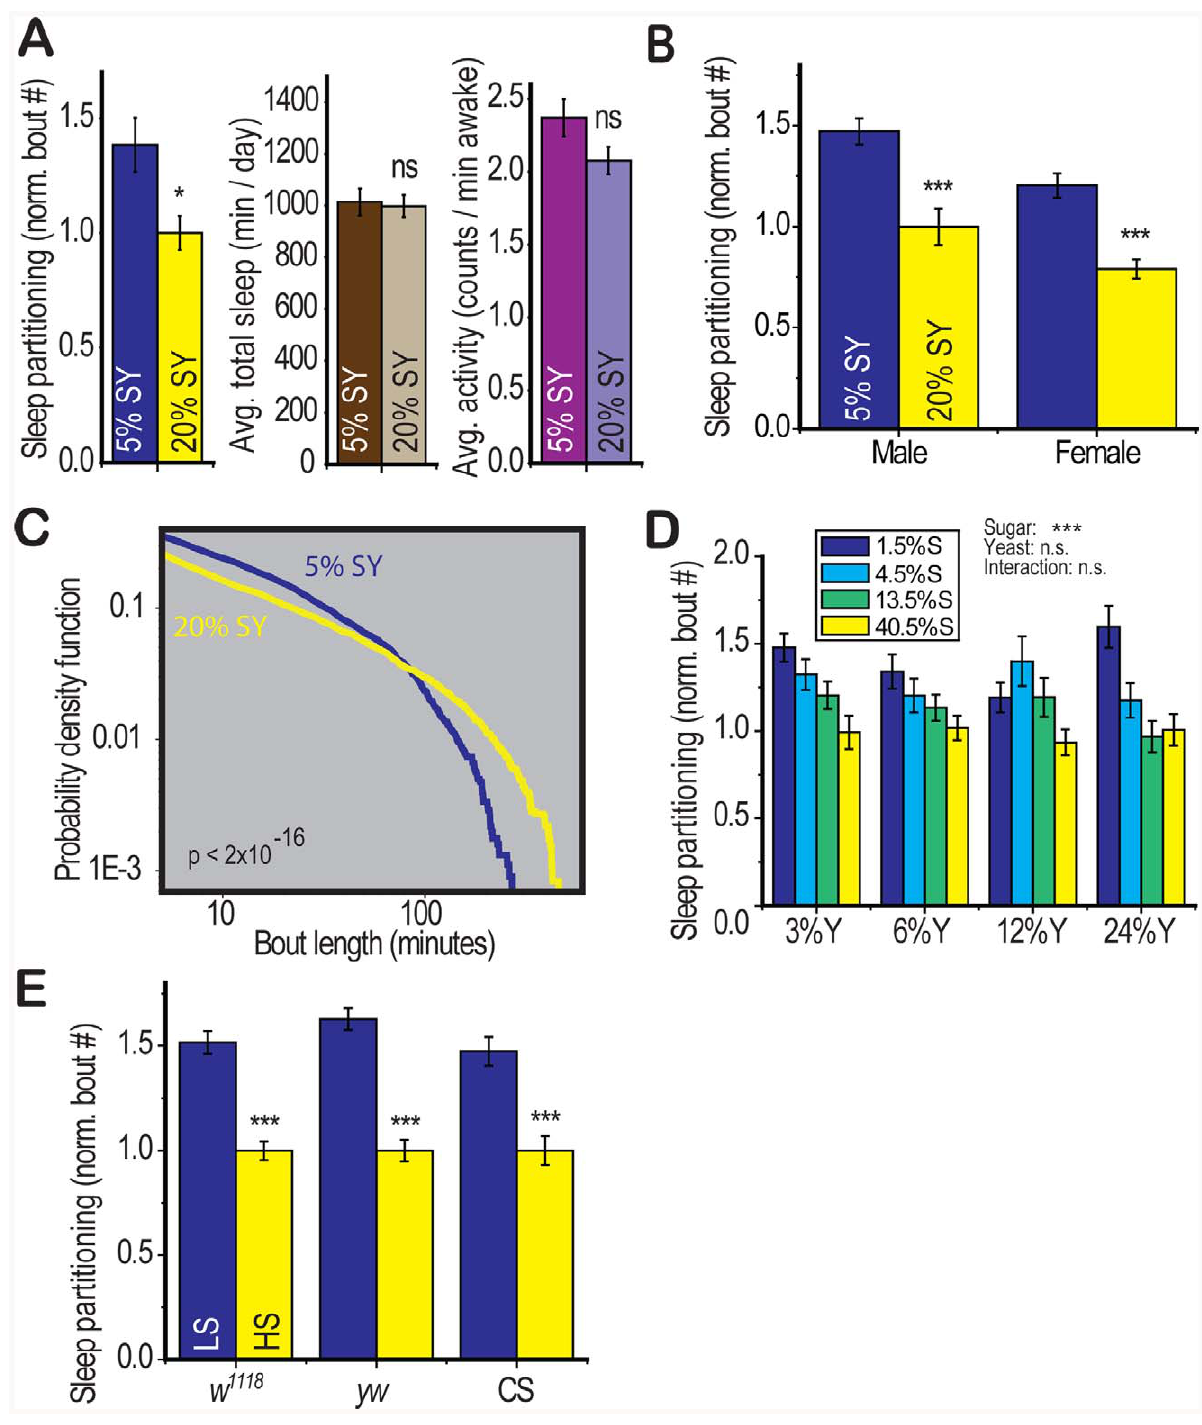
Figure 1. Dietary composition modulates sleep architecture. (A) Control ( yw ) flies fed 5:5% sucrose:yeast (5% SY) displayed an increase in the number of sleep bouts (sleep partitioning) over a 5 day recording period relative to those on 20% SY food. Total sleep and average waking activity (beam crosses per minute) were unaffected. (B) The response to diet was present in both males and females. (C) The distribution (probability density function) of sleep bout lengths over the same 5 day recording period revealed that the 5% SY diet resulted in a reduced number of long sleep bouts in favor of a larger number of short and medium-length bouts (p , 2 6 10–16, Kolmogorov-Smirnov test). (D) The carbohydrate (sucrose) component of the diet modulated sleep (p , 0.001) with no significant effect of yeast or sucrose:yeast interaction (two way ANOVA). Concentrations of sucrose (S) and yeast (Y) are shown as percentages by weight. (E) The effects of diet were robust in three control genotypes: w 1118 , yw , Canton S (CS) when flies were fed on a base of 2.5% yeast with either low (LS, 2.5%) or high sucrose (HS, 30%). Error bars represent mean + / 2 SEM for each group. *** p , 0.001, ** p , 0.01,* p , 0.05 for all statistical calculations. Significance values for t-tests between dietary conditions are shown above each set of bars and significance values for two-way ANOVA are shown above the graph, where applicable. See Figure S1 and Tables S1 and S2 for additional information.